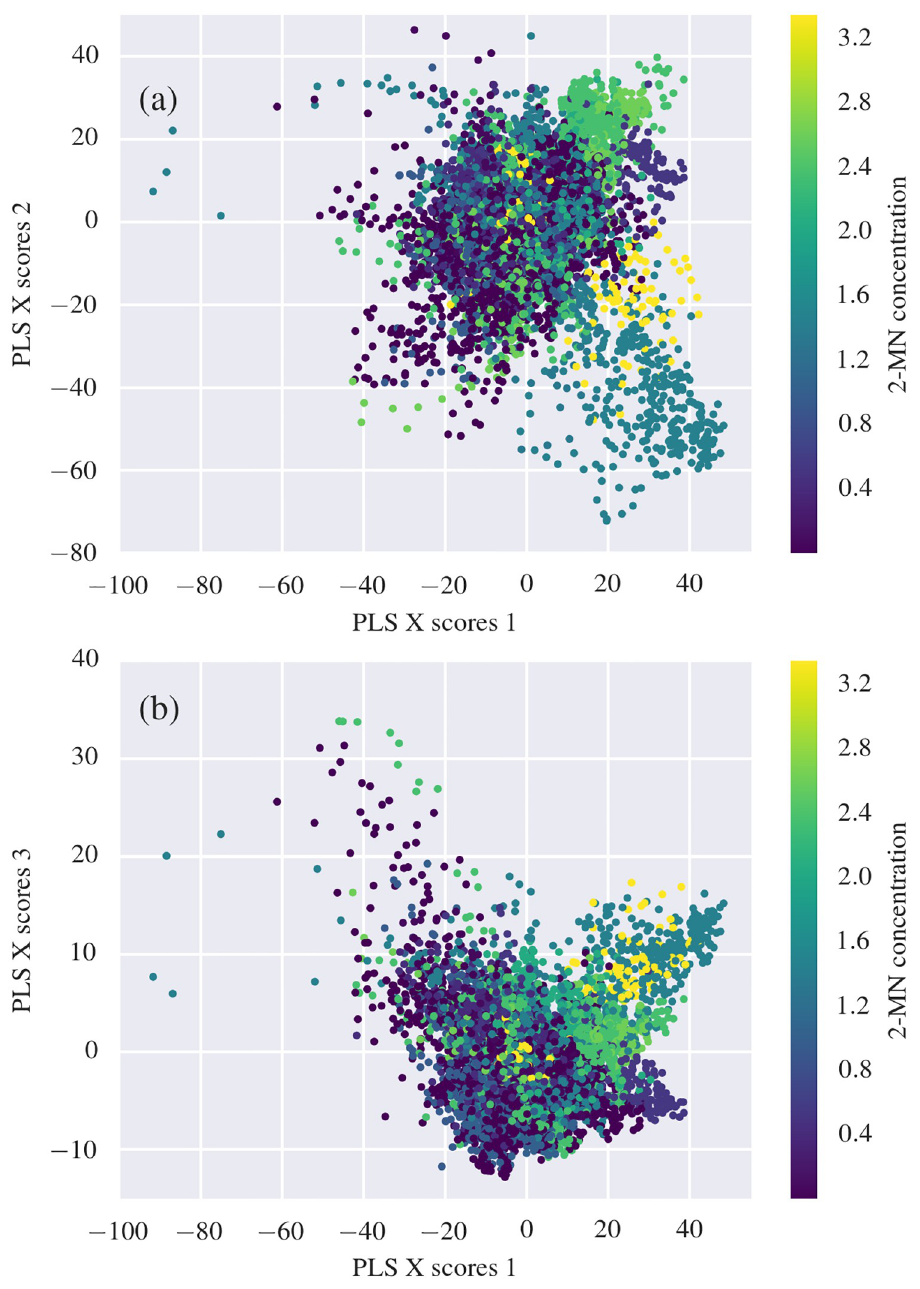
Fig 8. PLS scores for white corals. (a) shows scores for X latent variable 1 vs latent variable 2, (b) shows scores for X latent variable 1 vs latent variable 3. One dot corresponds to one spectrum (i.e. one hyperspectral image pixel) taken from a